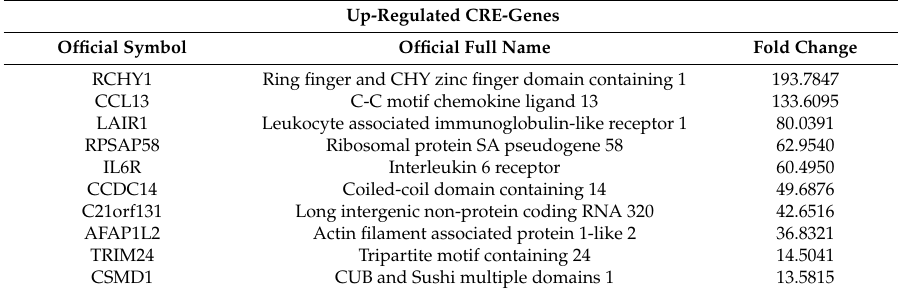
Figure 1. Gene expression changes triggered by epileptic disease. Microarray heat map shown genes that were differentially expressed and unchanged during epileptic episodes without treatment. A color code scale was used to show gene expression differences in logarithmic fold change units between the groups (red represents lower expression; green represents higher expression). Table 3. Most representative deregulated cAMP-response element-genes (CRE-genes) in pediatric patients with epilepsy in comparison with healthy children.